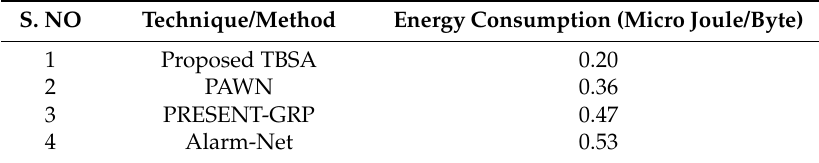
Table 3. Energy consumption comparison with security methods designed for